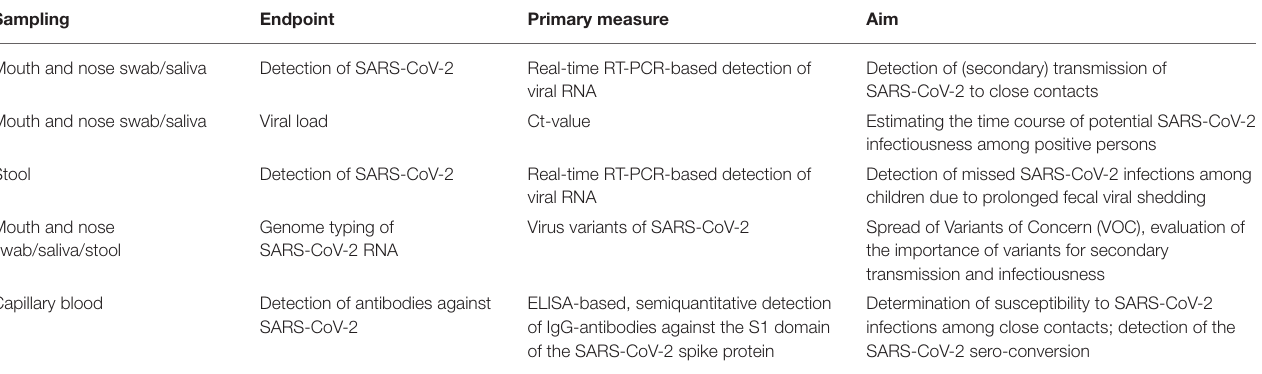
TABLE 1 | Biological samples and laboratory